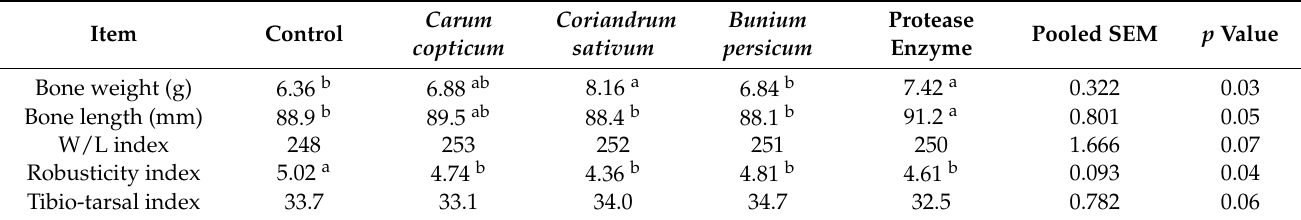
Table 4. Effect of addition of herbal plant feed additives and protease on bone characteristics in broilers.